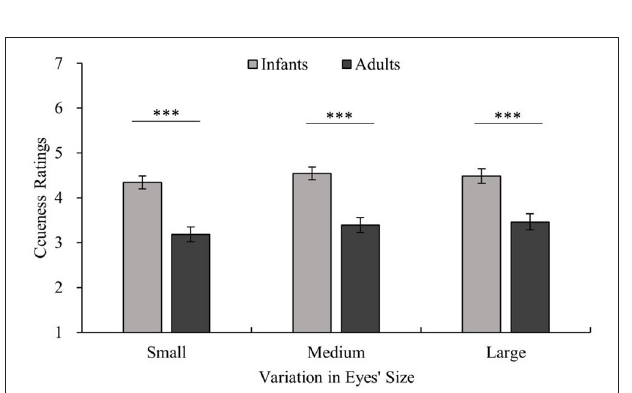
FIGURE 7 | Ratings for the cuteness of infants and adults with the same facial expression. The horizontal axis shows three types of facial expressions, and cuteness ratings are shown on the vertical axis. The light color indicates the infant stimuli, and the dark color indicates the adult stimuli. Adults < infants with the same facial expression, all *** p <